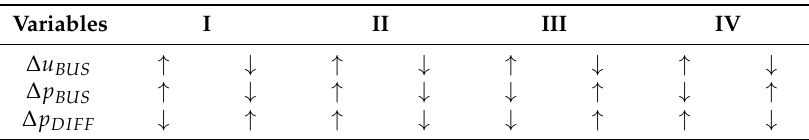
Figure 6. ( a ) Operating regions for power limited control (PLC) case; ( b ) Operating regions for maximum power point tracking (MPPT) case. Table 2. Definition of four operating regions for PLC case.